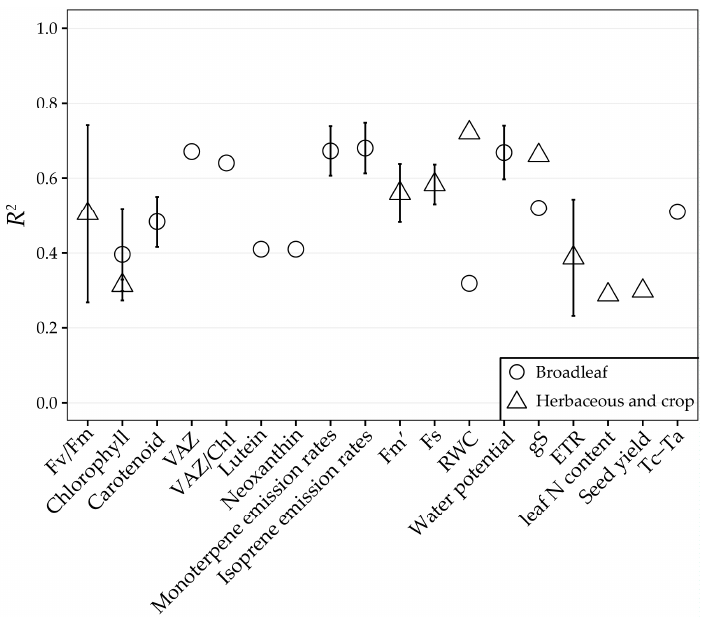
Figure 2. The mean values of coefficients of determination of the relationships between PRI and several physiological variables at the foliar level and short daily timescale. All the correlations were significant ( p < 0.05). Error bars indicate standard error.